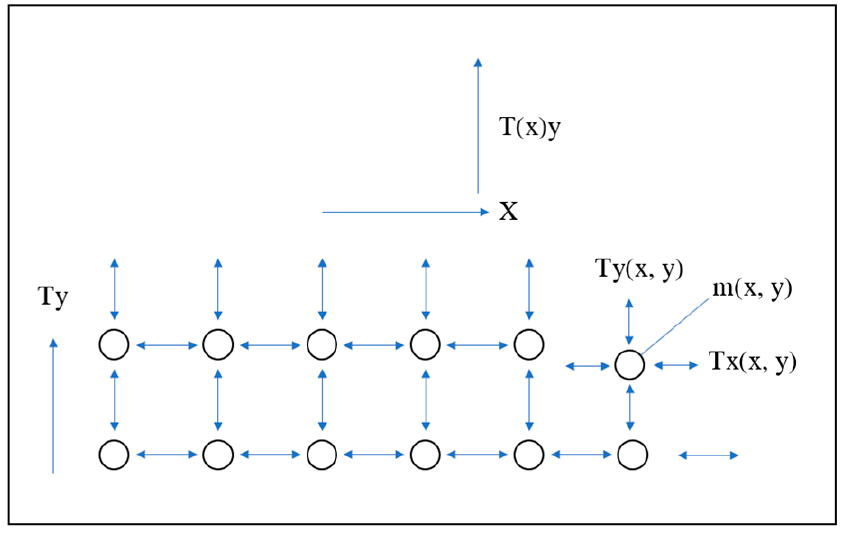
Figure 2. Mass and tension network for time-domain model [15].